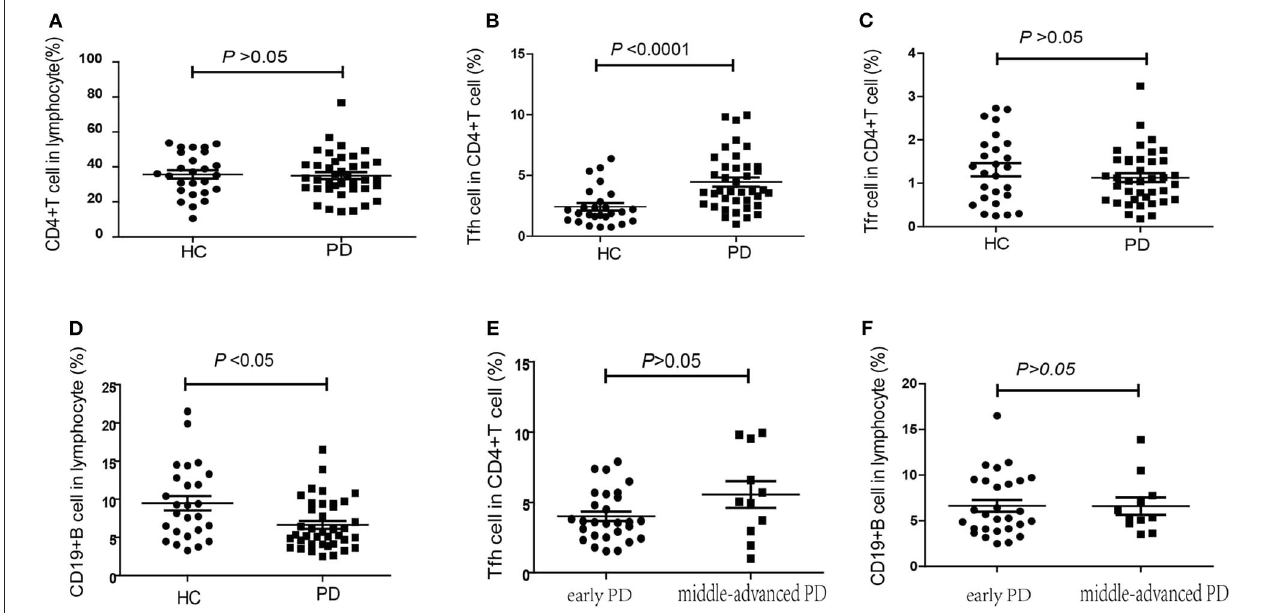
FIGURE 2 | The percentage of cTfh, cTfr and B cells in PD patients and HCs. (A) The comparison of the CD4 + T cells between PD patients and HCs ( P > 0.05). (B) The comparison of the cTfh cells between PD patients and HCs. The cTfh cells among CD4 + T cells was significantly higher in PD patients ( P < 0.0001). (C) A comparison of the cTfr cells in PD patients and HCs, but it was without significant difference ( P > 0.05). (D) A comparison of the CD19 + B cells in PD patients and HCs. The CD19 + B cells significantly lower in PD patients ( P < 0.05). (E) The comparison of the cTfh cells between early PD group and middle-advanced PD group ( P > 0.05). (F) A comparison of the cTfr cells in early PD group and middle-advanced PD group ( P >